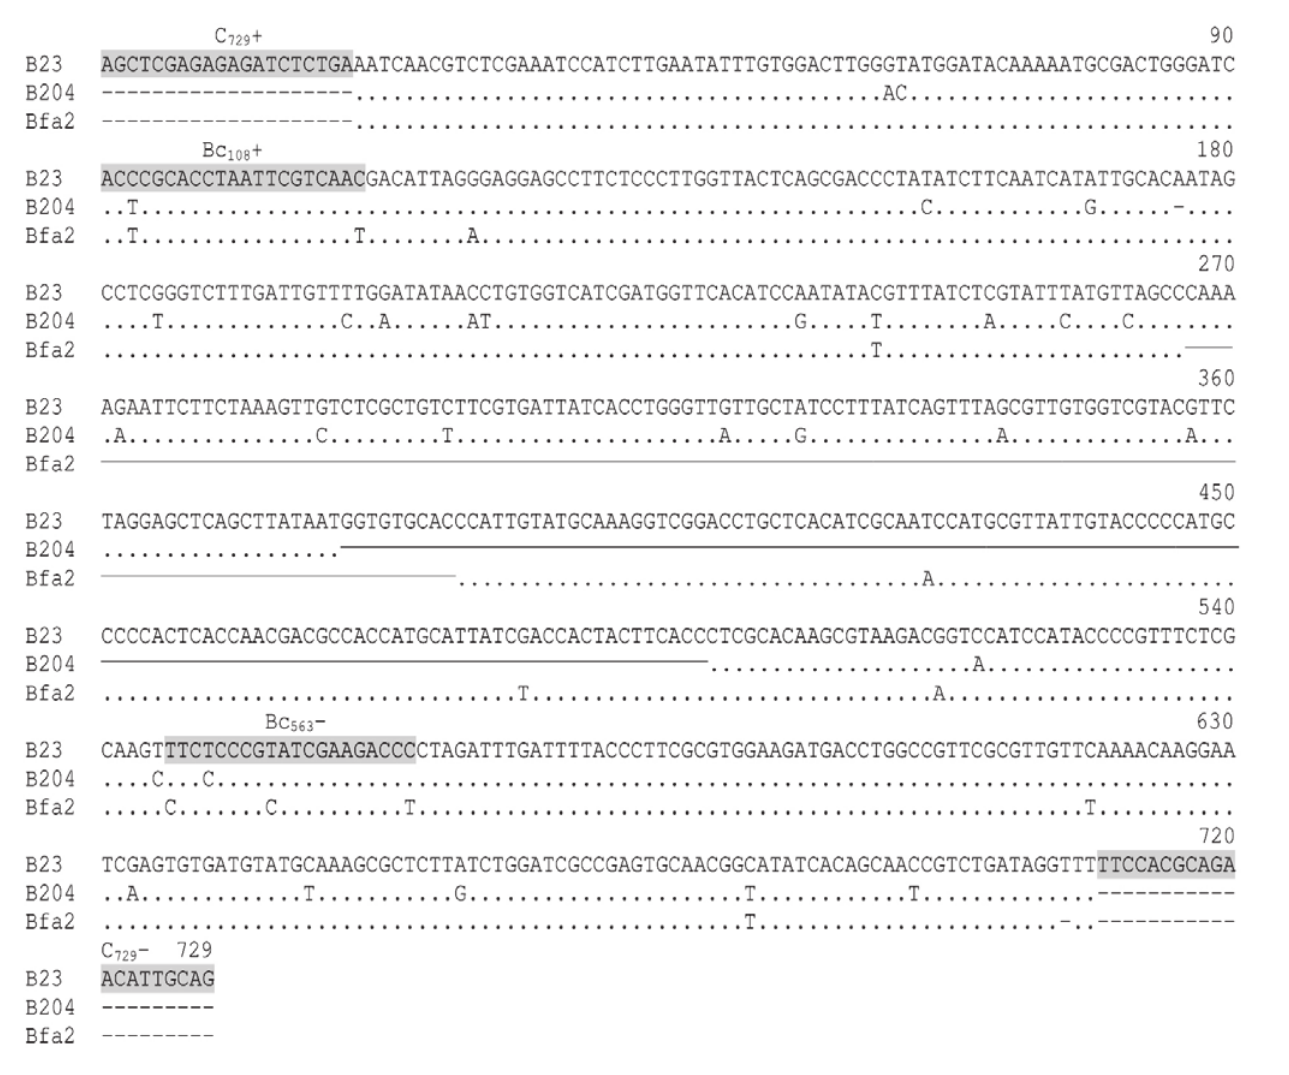
Fig. 1. Nucleotide sequence of the 0.76-kb fragment from Botrytis cinerea (EMBL accession No. AJ422103). Primers C 729+ , C 729– , Bc 108+ , and Bc 563– are shadowed. Mismatches between B. cinerea isolates B23 and B204, and B. fabae isolate Bfa2 are indicated by nucleotides below the sequence, and continuous lines indicate the deletion for B204 and